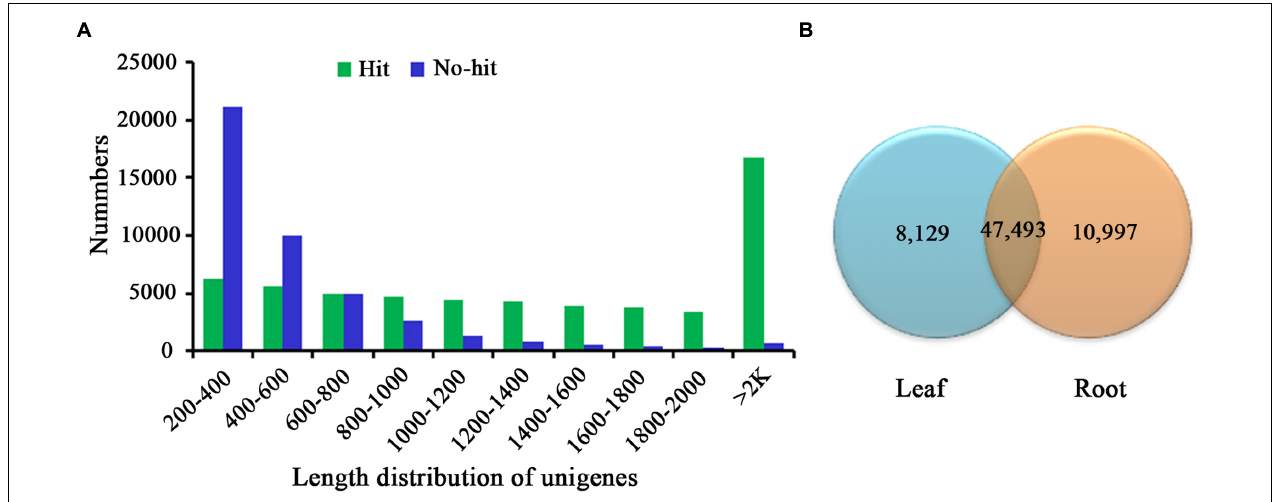
FIGURE 2 | Comparison of unigene length between hit and no-hit in UniProt database (A). The Venn diagram shows the number of expressed genes (RPKM ≥ 1) in samples of leaf and root (B)